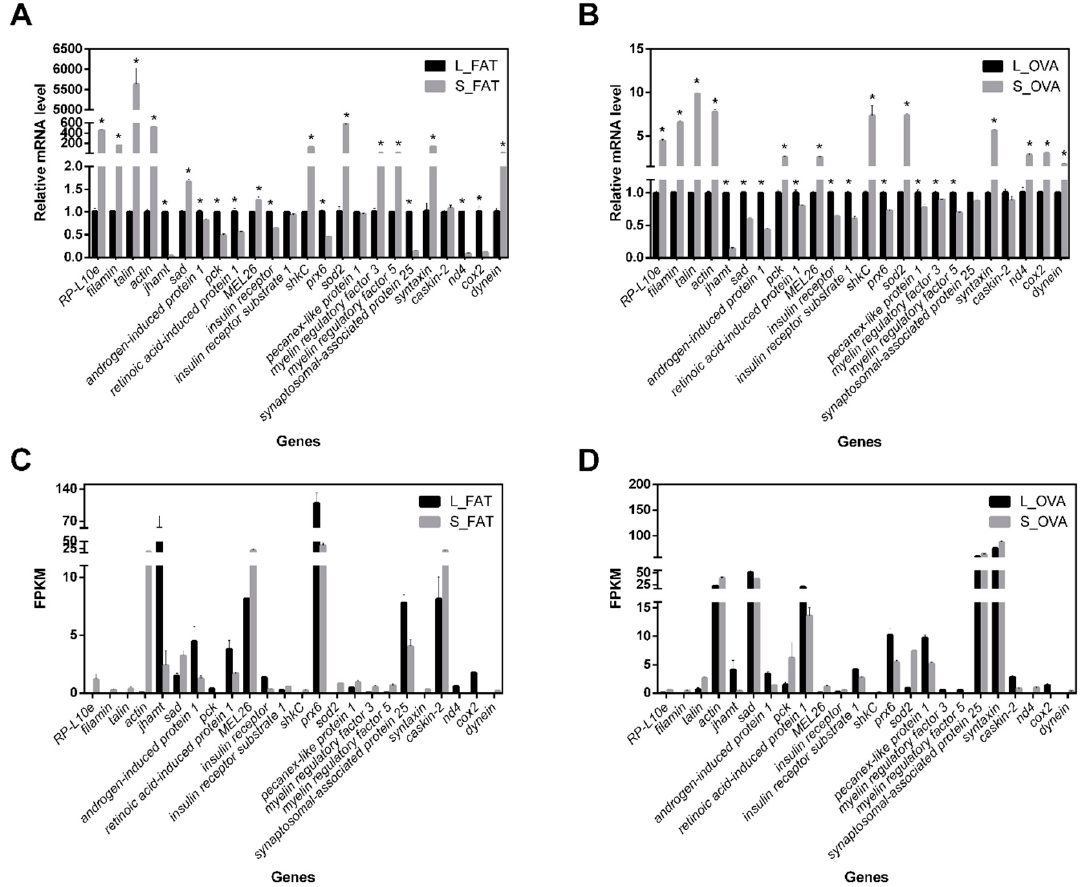
Figure 3. qRT-PCR validations of 24 DEGs in FAT and OVA groups. ( A ) Relative mRNA level of 24 DEGs in FAT group. ( B ) Relative mRNA level of 24 DEGs in OVA group. ( C ) FPKM value of 24 DEGs in FAT group. ( D ) FPKM value of 24 DEGs in OVA group. For each DEG, three technical replications were performed; ef-1 gene was used as internal control. For each treatment, three replications were performed. Values were reported as mean ± SE. * Indicates an error probability of p < 0.05 using Student's t -test.